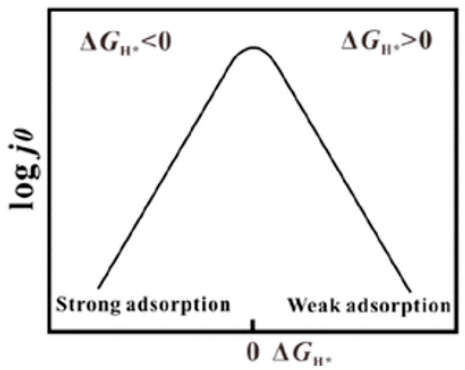
Figure 2. Relationship of log j 0 vs. ∆ G H ∗ for adsorbed protons H ∗ . Reproduced from [26], Copyright 2019, American Chemical Society.